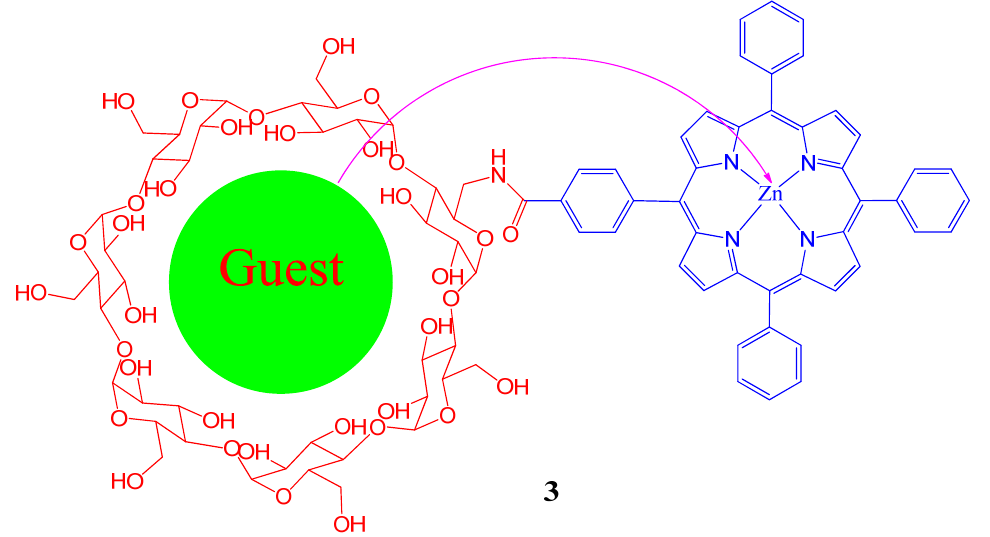
Figure 3. Energy transfer from the guest species to metalloporphyrin of the cyclodextrin-porphyrin conjugate.